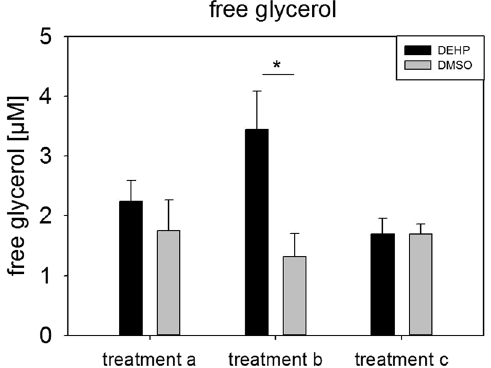
Figure 9. Measurement of free glycerol in SGBS derived adipocytes: The cells have been differentiated as described before and have been treated with DEHP and DMSO as control as followed: treatment a: exposure from d0–d4 and sampling at d4; treatment b: exposure at d4 for 3h and sampling at d4; treatment c: exposure from d0–d4 and sampling at d8. Statistics: Student’s t-test, N = 4, n = 3.